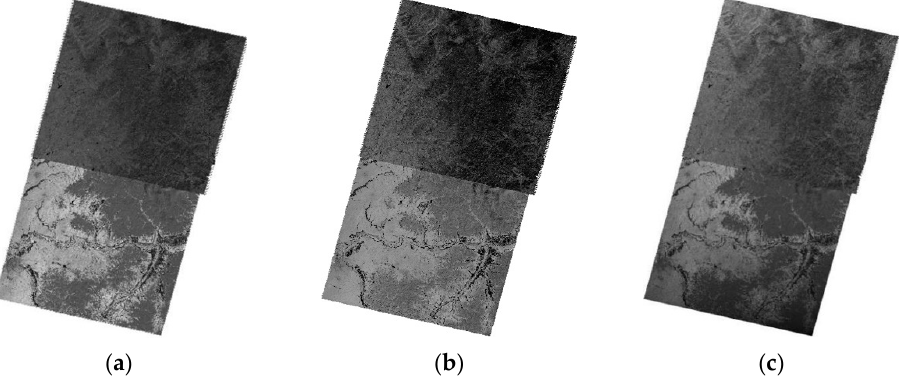
Figure 18. Compare with results by different method. ( a ) Original image. ( b ) Result by using histogram equalization method. ( c ) Result by using local to global radiometric balancing.